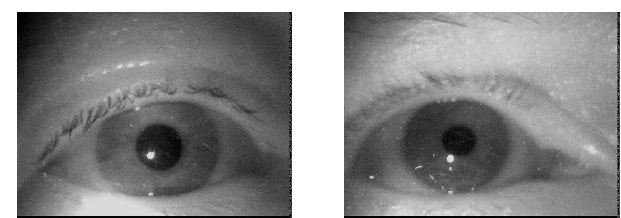
Figure 1 . Example eye images of two subjects showing dust particles in the focus layer of the camera (because they are best visible in print). Most dust particles in our data were placed slightly outside of the focus layer and therefore